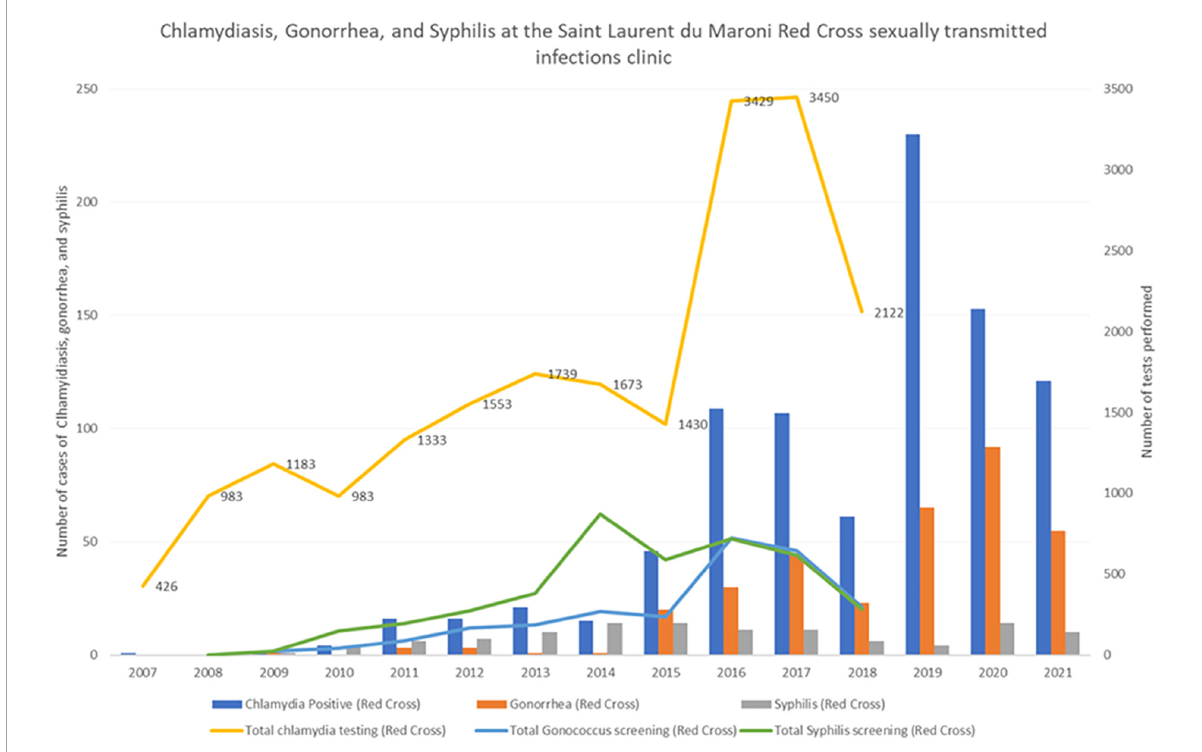
FIGURE11 In Saint Laurent du Maroni’s red cross STI clinic testing activity and the number of diagnoses of sexually transmitted diseases (Syphilis, gonorrhea, and chlamydiasis) has greatly increased over time, notably since the addition of